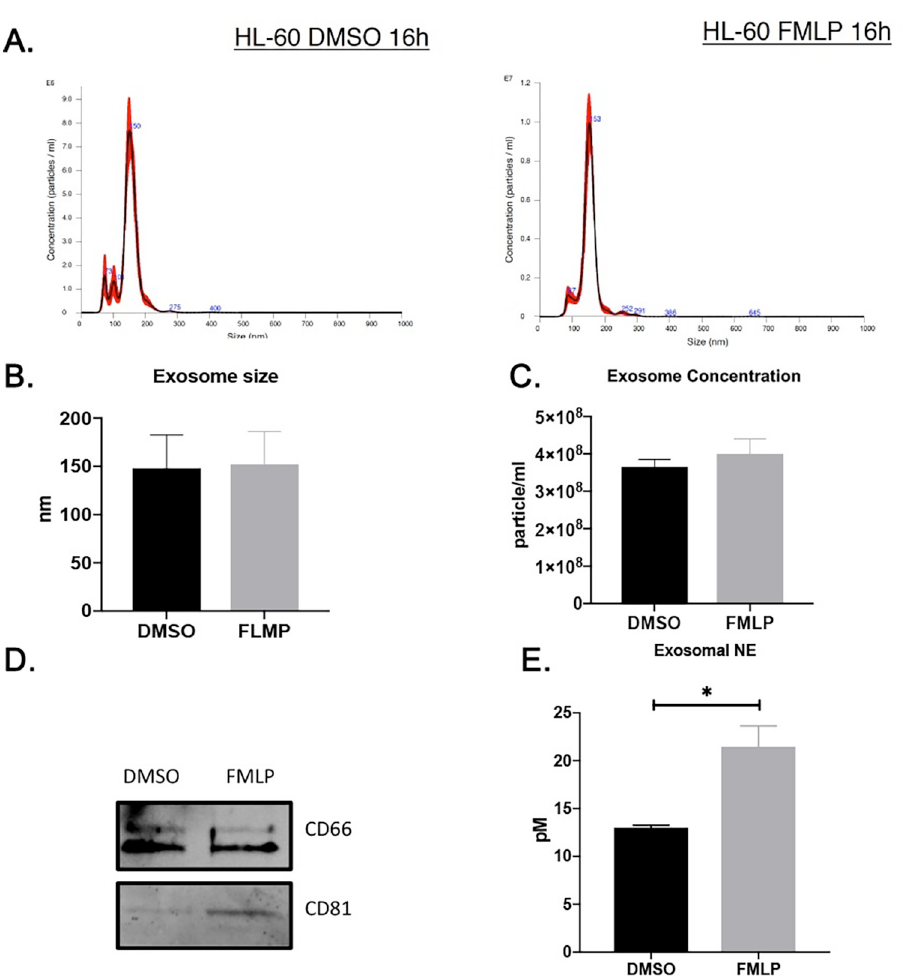
Fig 5. Exosomes from activated neutrophil-like cells carry surface neutrophil elastase (NE) in SARS-CoV2 patients. (A) The size and concentration of the exosome from activated quiescent exosomes, assessed using nano tracker. (B) Similar size and (C) concentration of the quiescent and activated exosomes. (D) Exosomal markers of CD66 and CD81 assessed by western blot analysis. (D) The levels of NE in the exosomal fractions assessed by ELISA, � p < 0.05 (two-tailed student’s